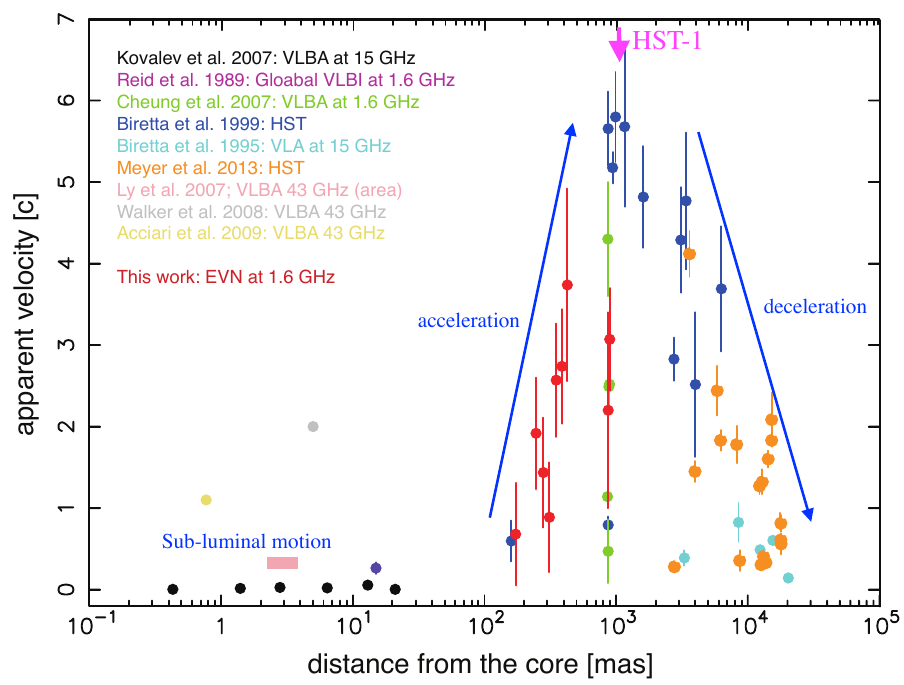
Figure 3. Velocity field measurements in the jet of M87 from parsec to kilo-parsec scales. The stationary feature HST-1 is at a distance of 100 parsecs from the central engine. The highest speeds are measured ∼ close to the position of HST-1. (Credit: Asada et al. [65], reproduced with permission c (cid:13)